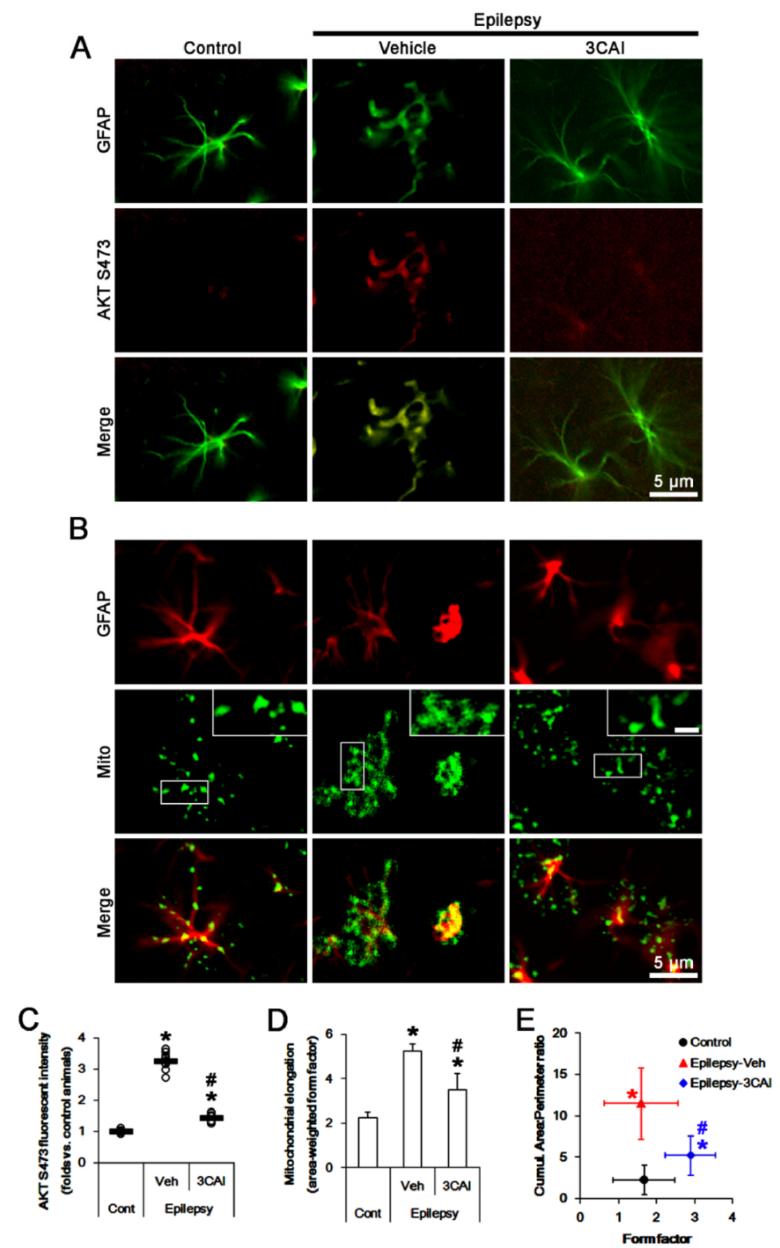
Figure 8. Effects of 3CAI on AKT S473 phosphorylation and mitochondrial length in CA1 astrocytes of control and epileptic rats. As compared to control animals (Cont), AKT S473 phosphorylation and mitochondrial length are increased in CA1 astrocytes in epileptic rats. 3CAI reduces AKT S473 phosphorylation and mitochondrial length in CA1 astrocytes, as compared to vehicle (Veh). ( A , B ) Rep- resentative photos demonstrating astroglial AKT S473 phosphorylation ( A ) and mitochondrial mor- phology ( B ) in CA1 astrocytes. ( C – E ) Quantifications of AKT S473 phosphorylation (mean ± S.E.M.; *, # p < 0.05 vs. control and vehicle-treated epileptic rats, respectively; n = 7, respectively, ( C )), mito- chondrial elongation index (area-weighted form factor, mean ± S.E.M.; *, # p < 0.05 vs. control and vehicle-treated epileptic rats, respectively; n = 7, respectively, ( D )) and the cumulative area:perimeter ratio (an indicative of the transition from elongated, isolated mitochondria to a reticular network or aggregation of interconnected mitochondria) and the form factor (a parameter as transition from the sphere to elongated, complex shaped, but still isolated mitochondria; mean ± S.E.M.; *, # p < 0.05 vs. control and vehicle-treated epileptic rats, respectively; n = 7, respectively, ( E